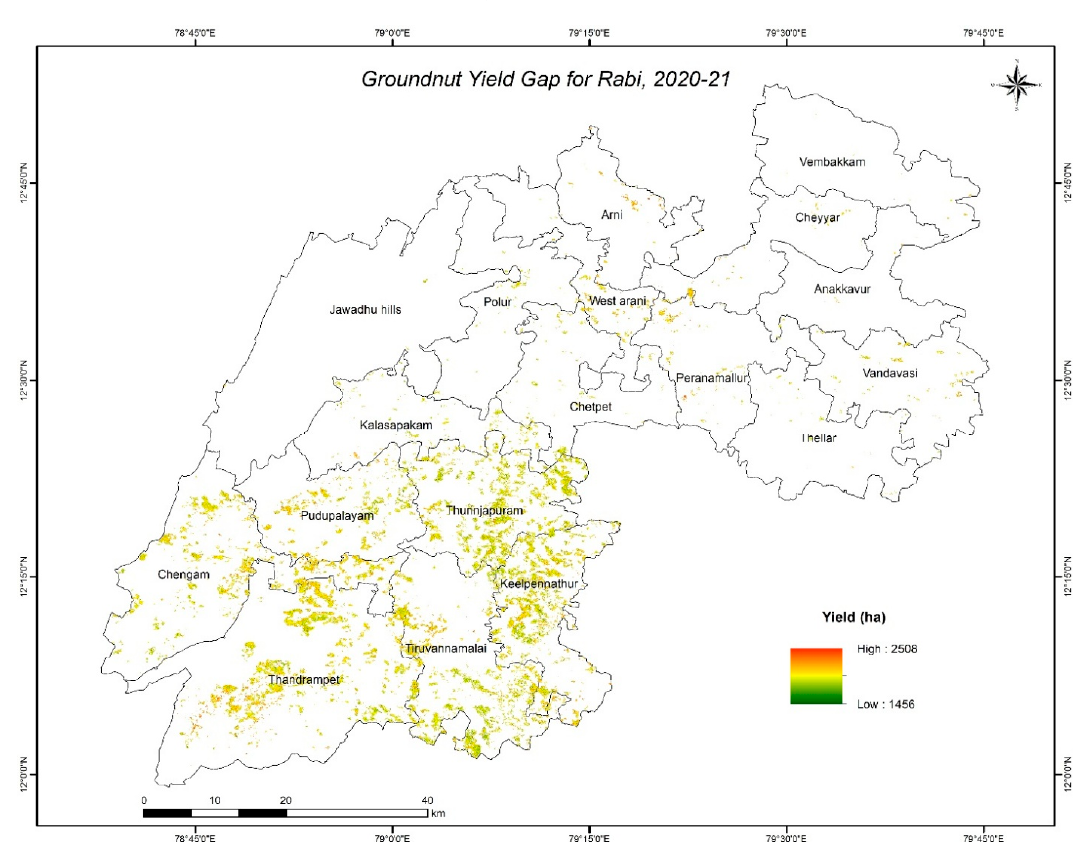
Figure 10. Peanut yield gap for Tiruvannamalai district during Rabi 2020–2021.